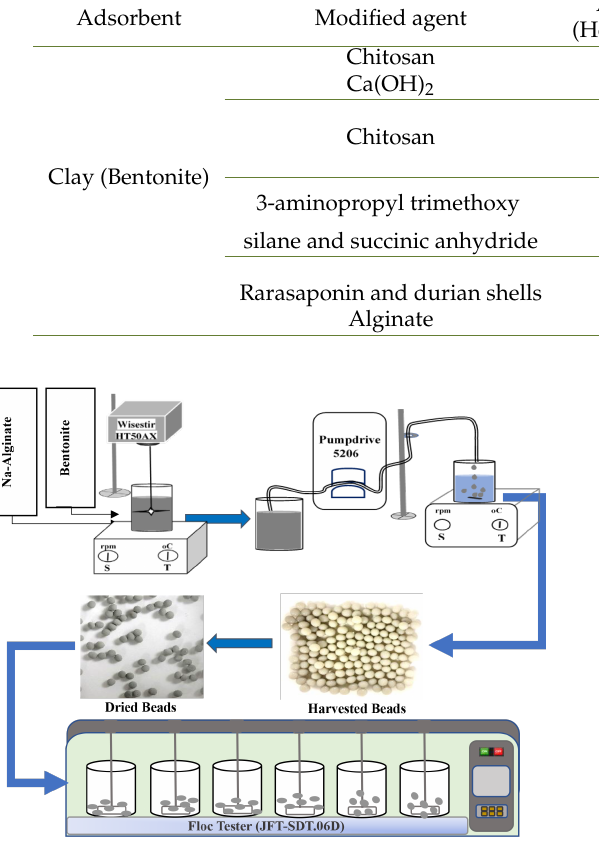
Fig. 1. Study scheme used in this study to remove Fe (II) by using Alginate-composite